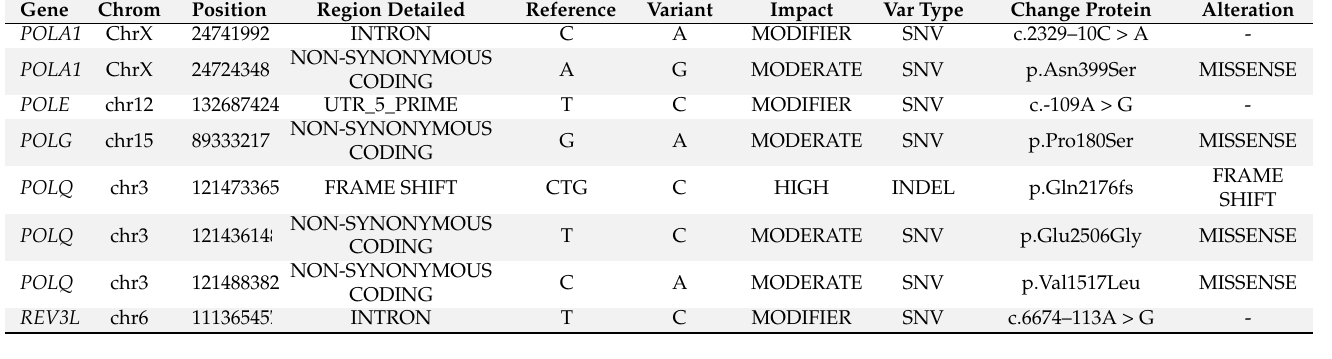
Table 2. New variants found in the Indigenous population from the Brazilian Amazon.